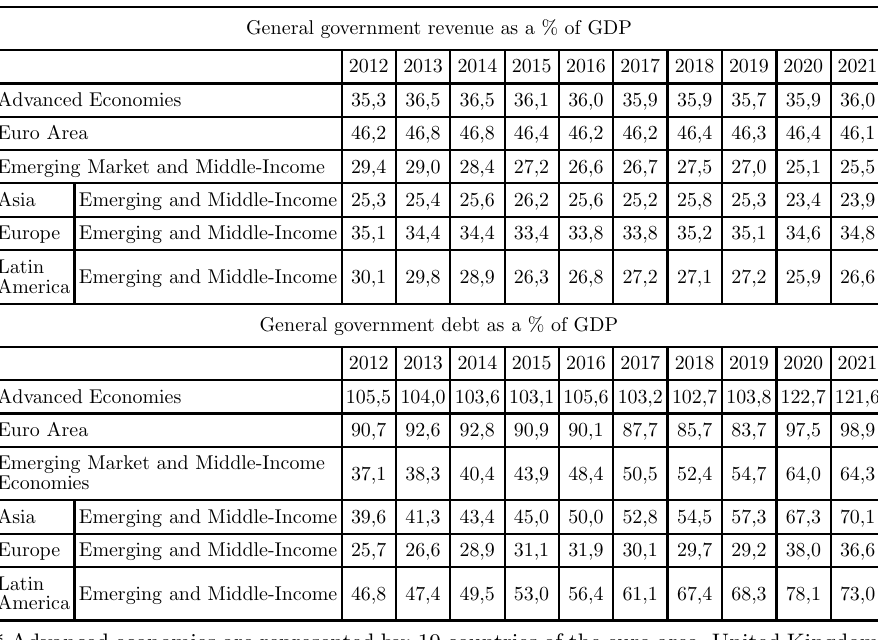
The comparison of fiscal space in the advanced and emerging and middle-income economies General government revenue as a % of